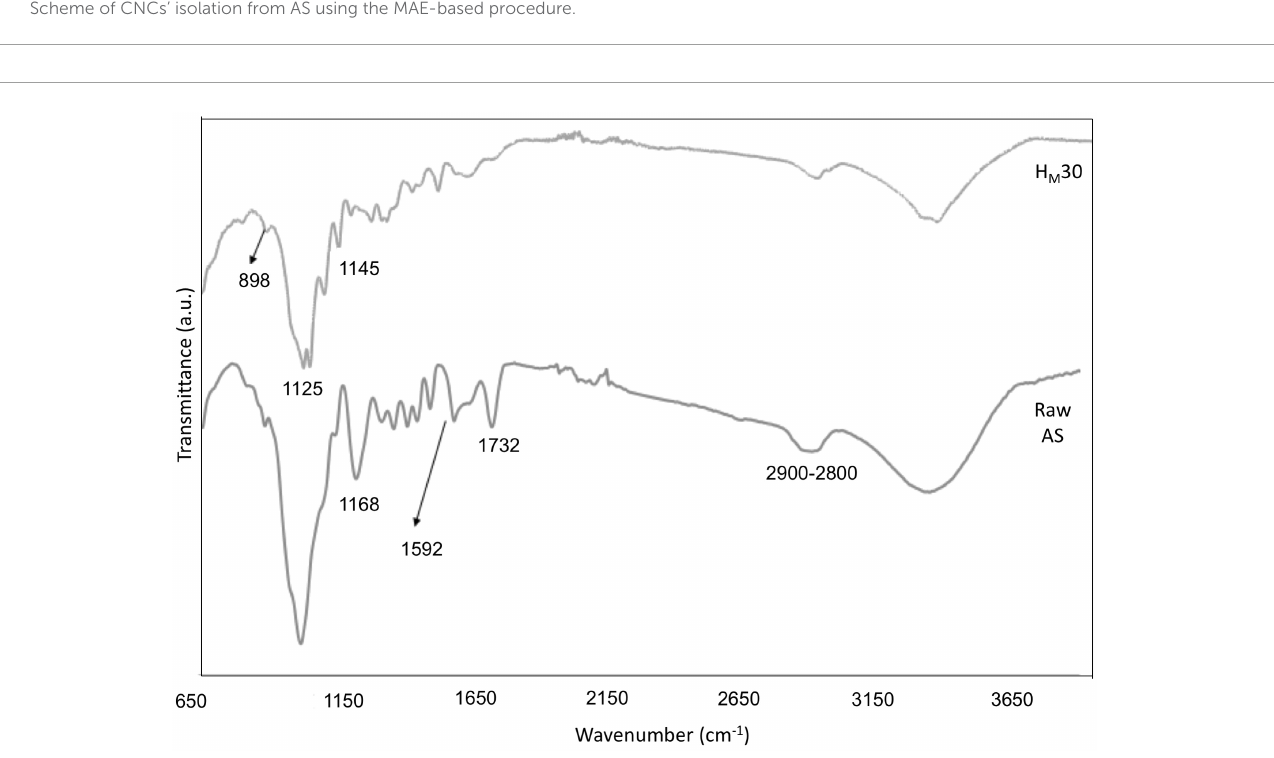
FIGURE9 FTIR spectra of raw AS and CNCs obtained under optimal conditions of the MAE procedure (H M 30).